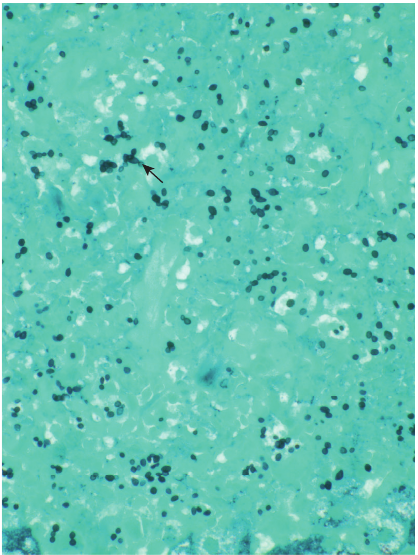
Figure 2: Grocott-Gomori methenamine silver stain: intracellular budding yeast